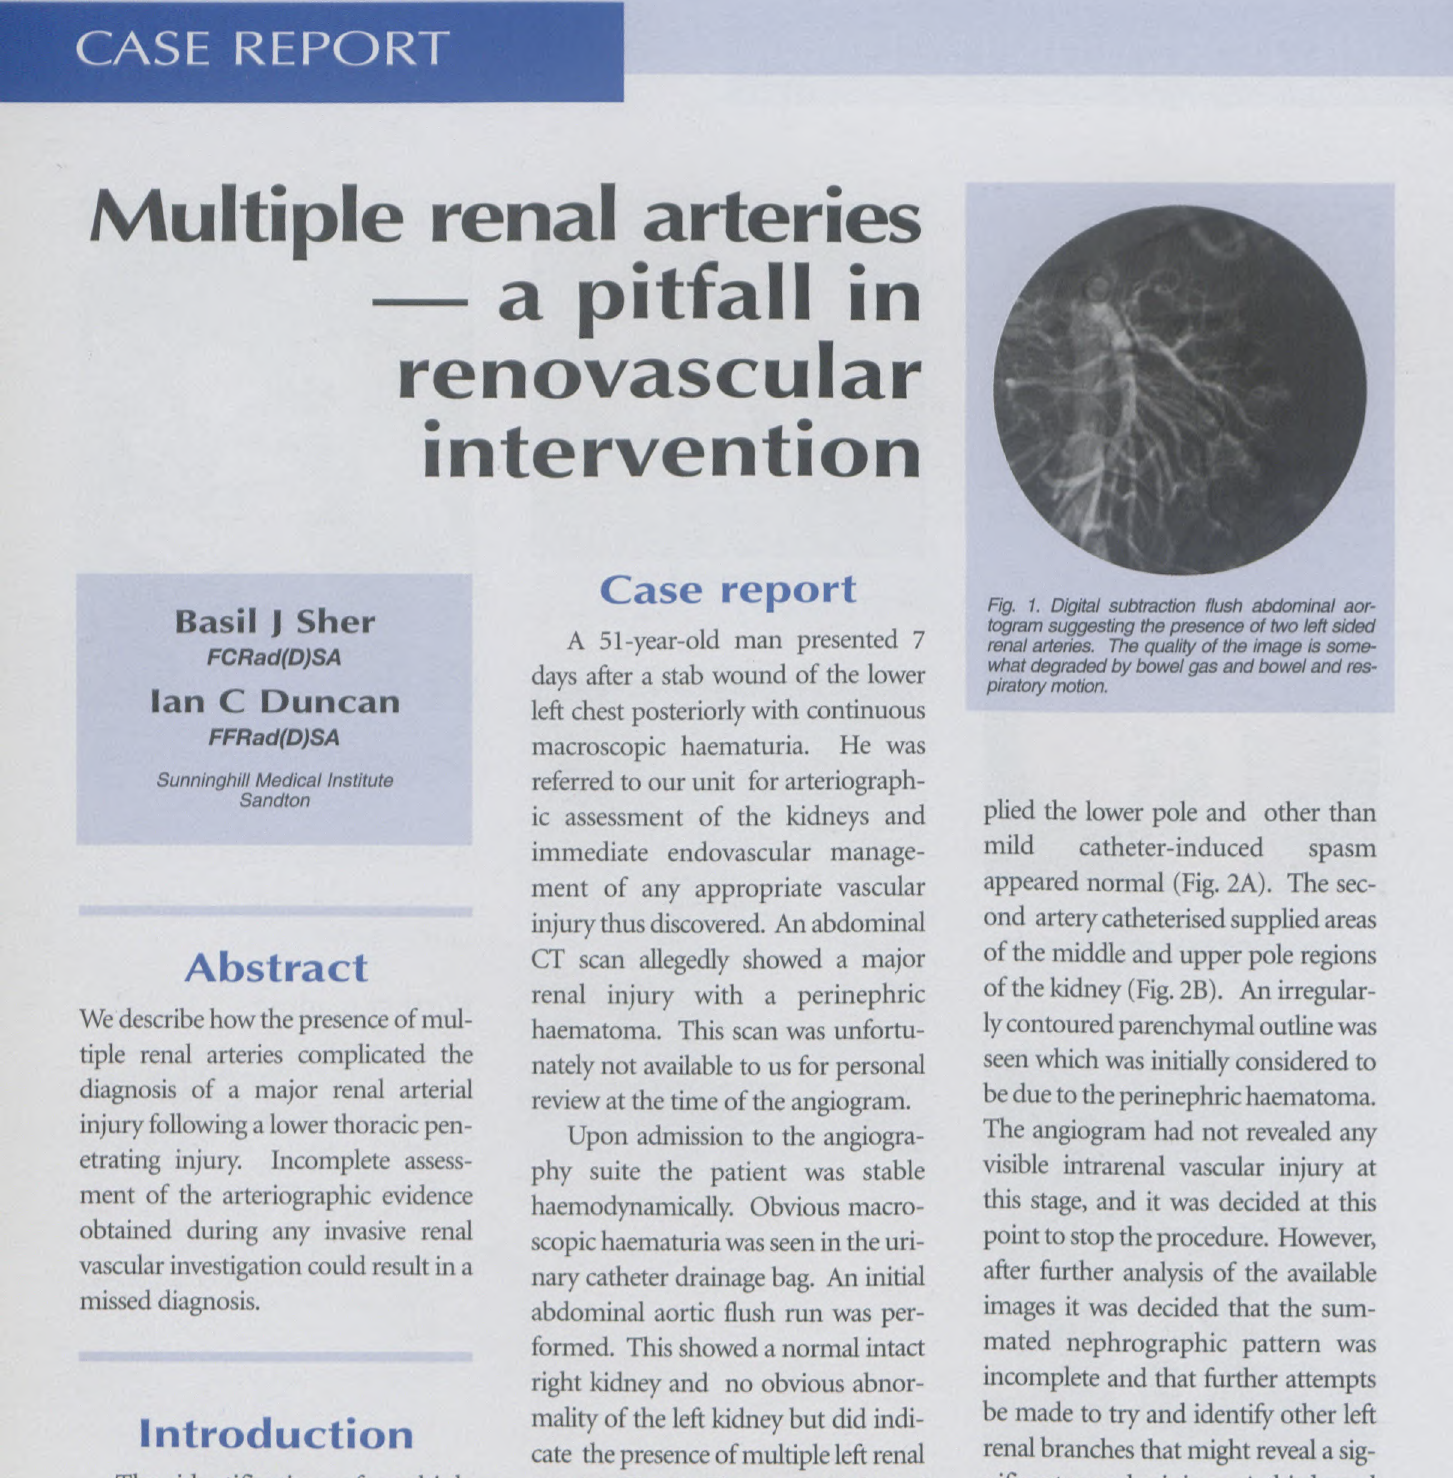
Fig. 1. Digital subtraction flush abdominal aor- togram suggesting the presence of two left sided renal arteries. The quality of the image is some- what degraded by bowel gas and bowel and res- piratory